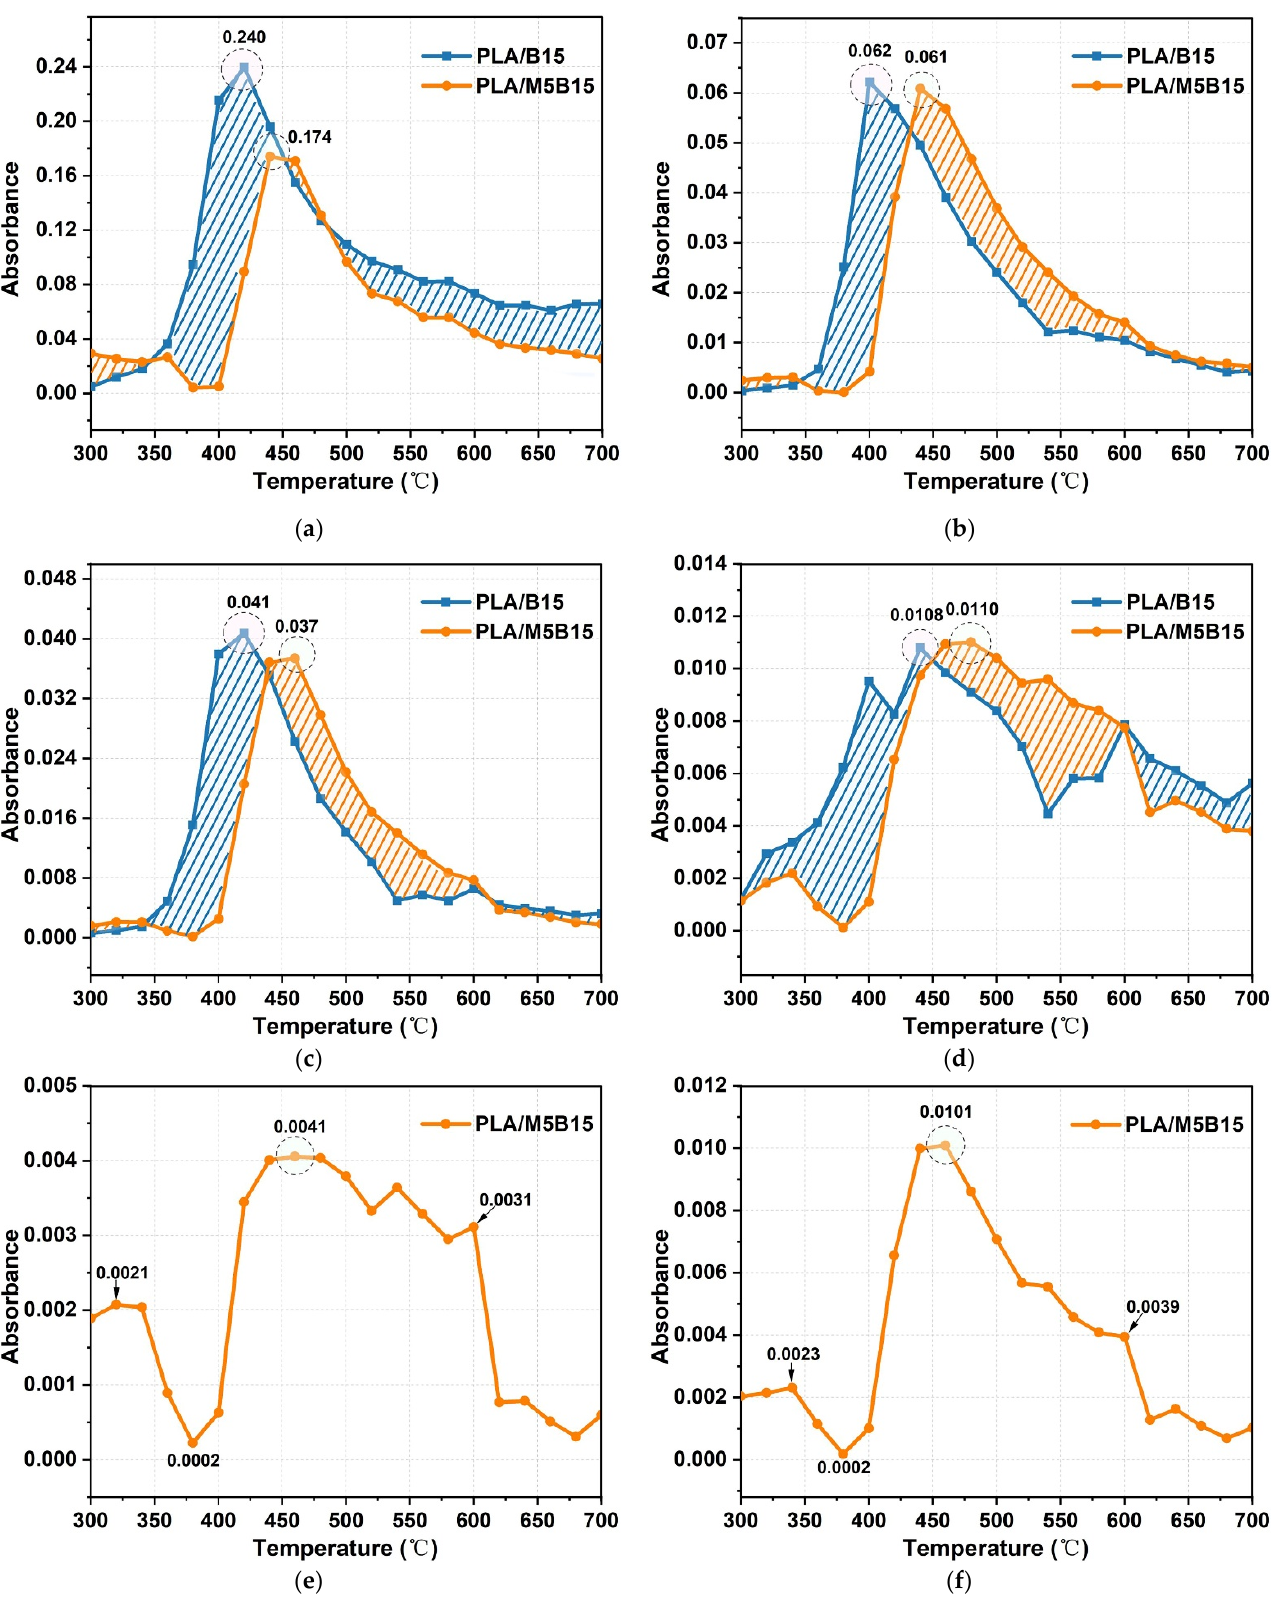
Figure 8. Absorbance of pyrolysis gaseous products for PLA/B15 and PLA/M5B15: ( a ) CO 2 ; ( b ) CO; ( c ) C=O; ( d ) CH 3 /CH 2 ; ( e ) NH 3 ; ( f ) P-O-C.